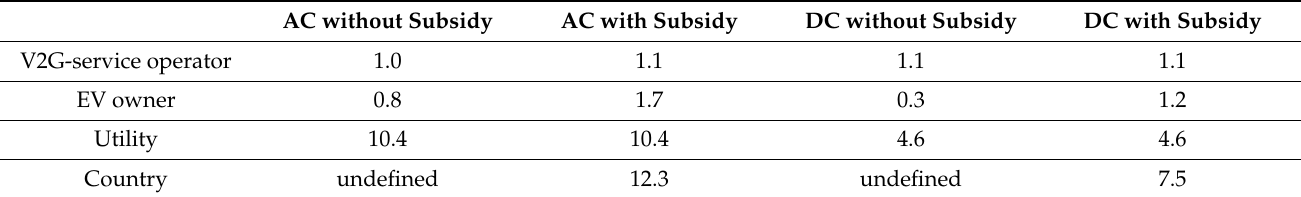
Figure 7. Stakeholders’ BCRs. Table 4. Stakeholders’ BCRs.